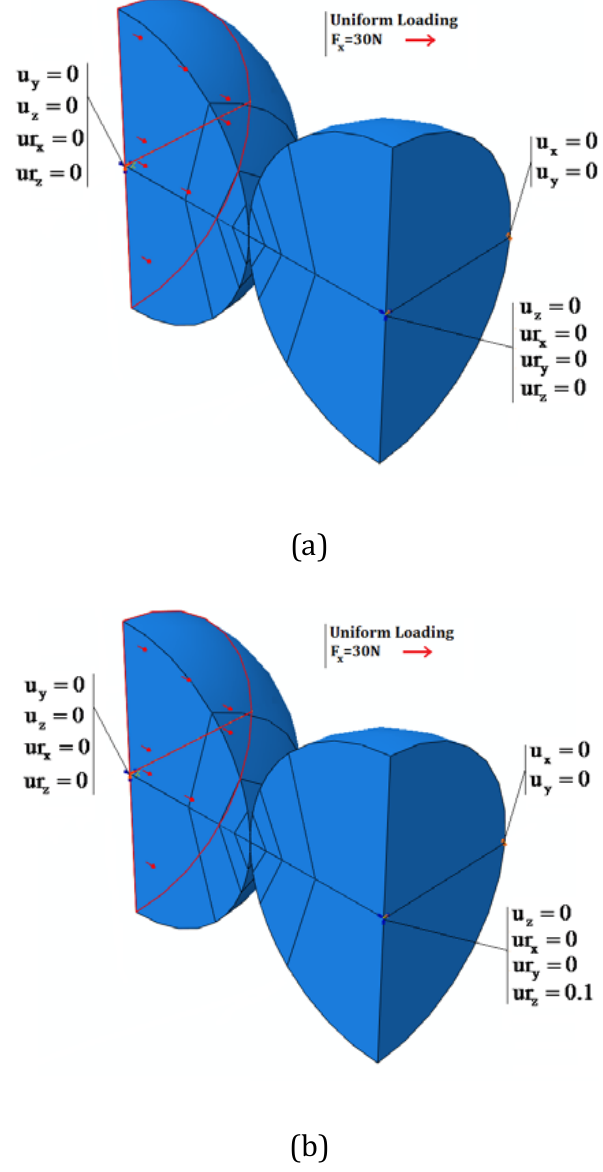
Figure 4. QS model boundary conditions and loads in static (a) and dynamic (b) phases (rotation in radians).